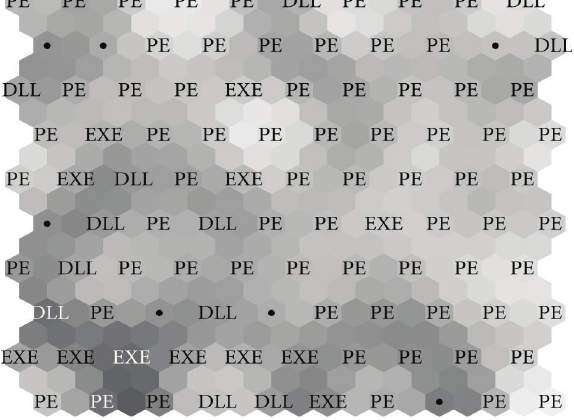
Figure 4: Distances between reference vectors of hexagonal neigh- boring units on File Type.